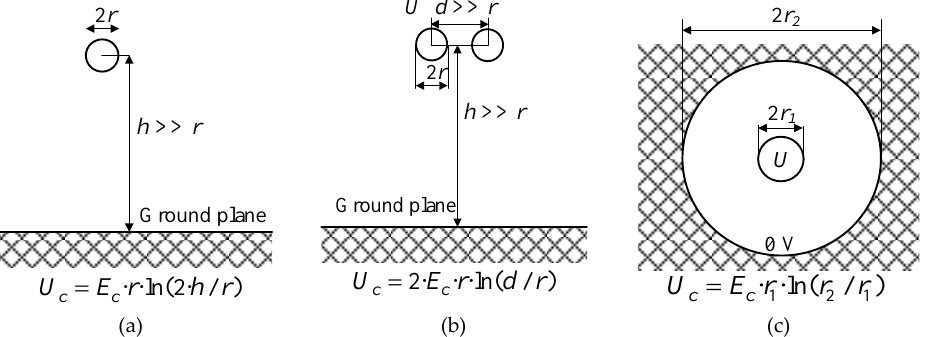
Figure 2. Relationship between the AC corona inception voltage U c and the corona inception voltage gradient E c [14,50]. ( a ) Single conductor; ( b ) Bifilar configuration; ( c ) Concentric cylinders.